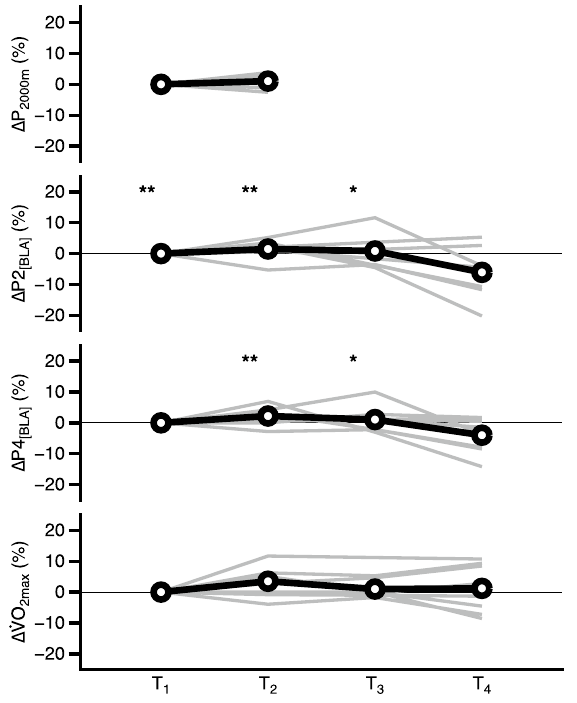
Figure 4. Individual (grey) and average (arithmetic mean in black and bold) percentage changes in ˙ V performance and maximum oxygen consumption ( O 2max ) of eight rowers within one season. T 1–4 represent time points of measurement in November, March, May and around the individual rower’s main competition (July–September). P 2000m average mechanical power output during all-out 2000 m ergometer test, P2 [BLA] and P4 [BLA] mechanical power output associated with blood lactate concentration of 2 or 4 mmol·L −1 , respectively, ˙ V